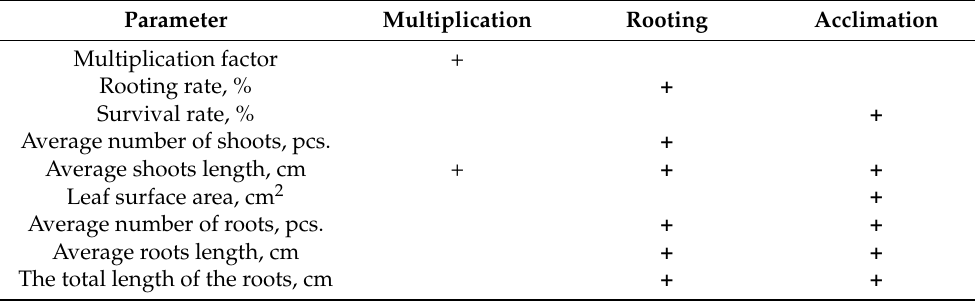
Table 2. List of the measured morphometric indicators of